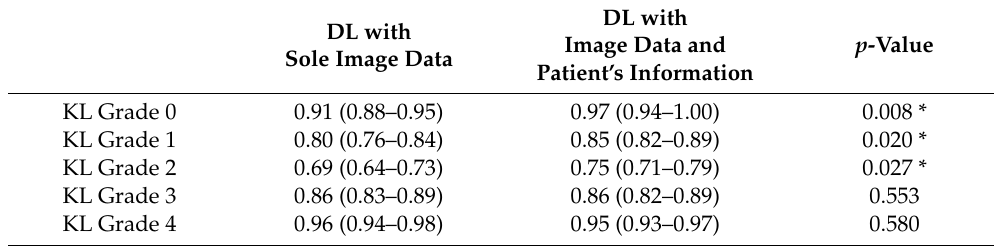
Table 2. Comparison of AUC of test sets.